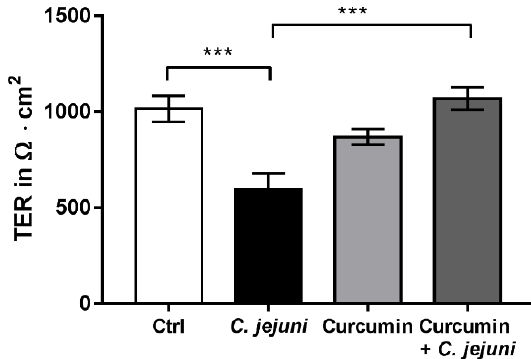
Figure 2. Curcumin protects against C. jejuni -induced barrier disruption in co-culture. Cells were treated with 50 µM curcumin and infected with C. jejuni for 48 h ( n = 13, *** p < 0.001, one-way ANOVA with Bonferroni correction for multiple comparisons).